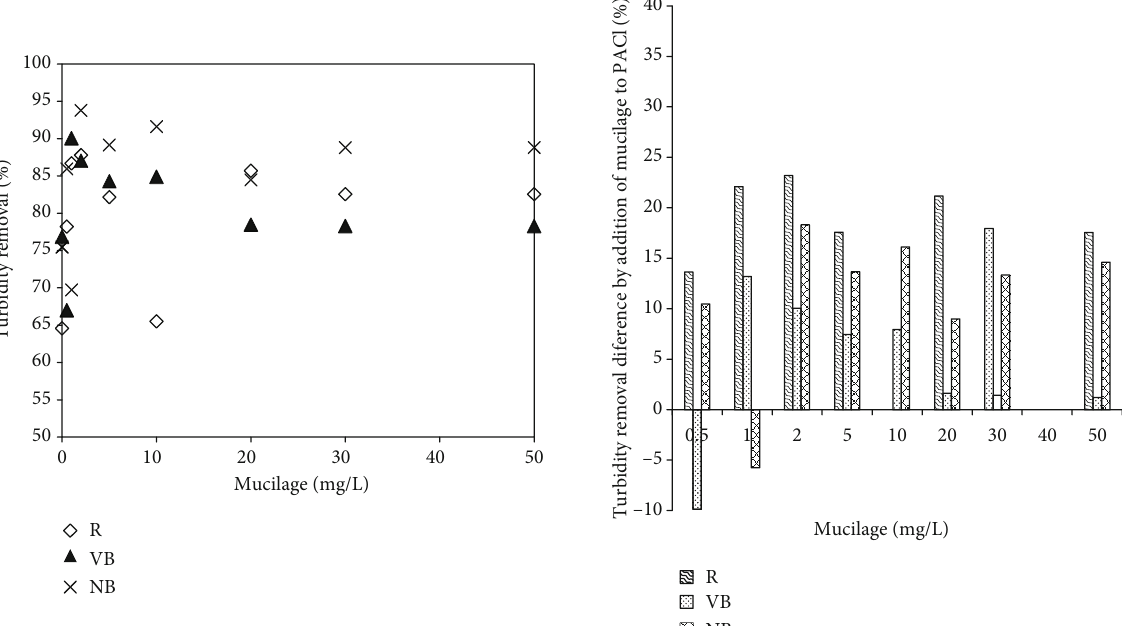
Figure 4: Turbidity removal e ffi ciency of mucilage in combination with PACl.